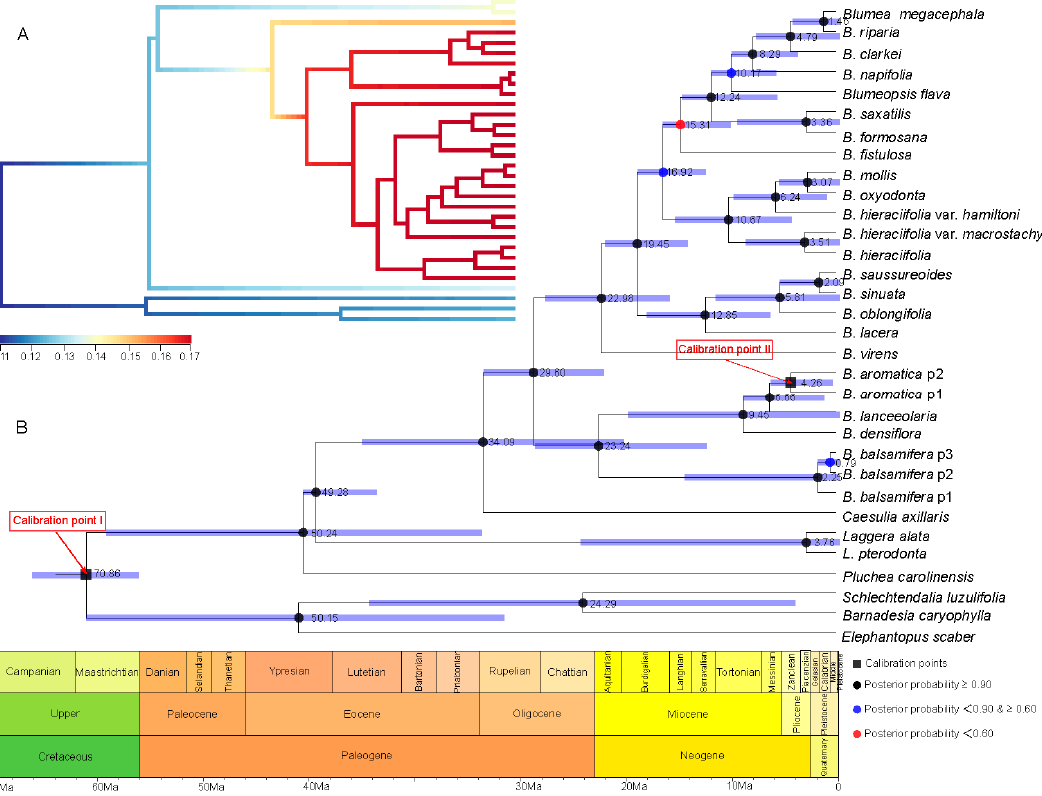
Figure 5. Divergence time estimation and speciation ‒ extinction rates analysis based on the root age of Asteraceae as 76–66 Ma [27] and the combined sequence. ( A ) The speciation ‒ extinction rates analysis performed by BAMM [23] and BAMMtools [24]. ( B ) The divergence time estimation performed by BEAST 1.10.4 [25], and geological time scale visualized with the strap package [26]. The values beside nodes indicate the estimated median time of di ff erentiation, and error bars indicate 95% HPD of di ff erentiation. The black squares on nodes indicate calibration time. The circles with black, blue and red respectively indicate posterior probability more than 0.90, 0.60-0.90, and less than 0.60. Two series of divergence time were estimated with two di ff erent root ages of